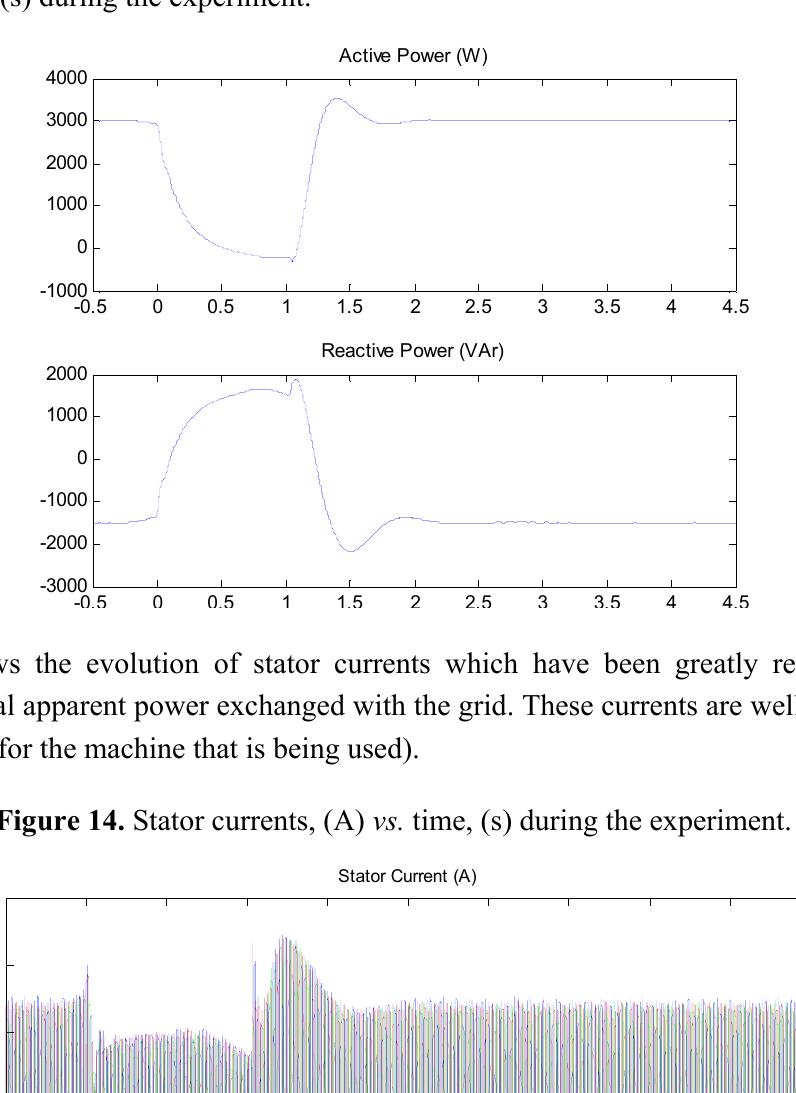
Figure 13. Active power (top, W) and reactive power (bottom, VAr) exchanged with the grid vs. time (s) during the experiment.